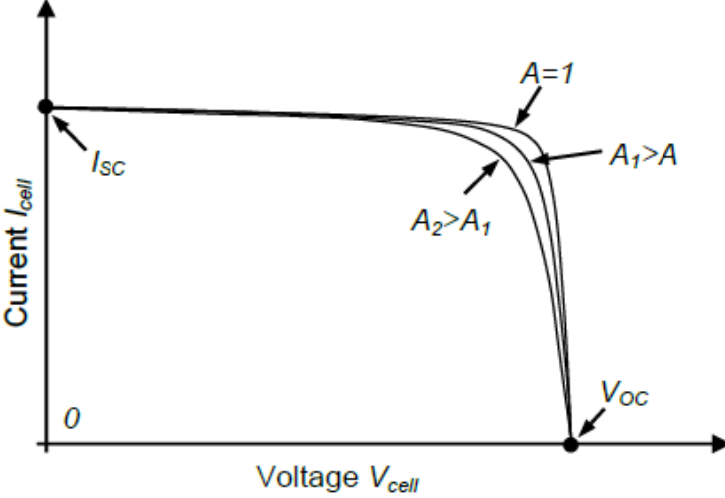
Figure 4. Effect of A -value on the I – V characteristics ’ shape within the arc area.